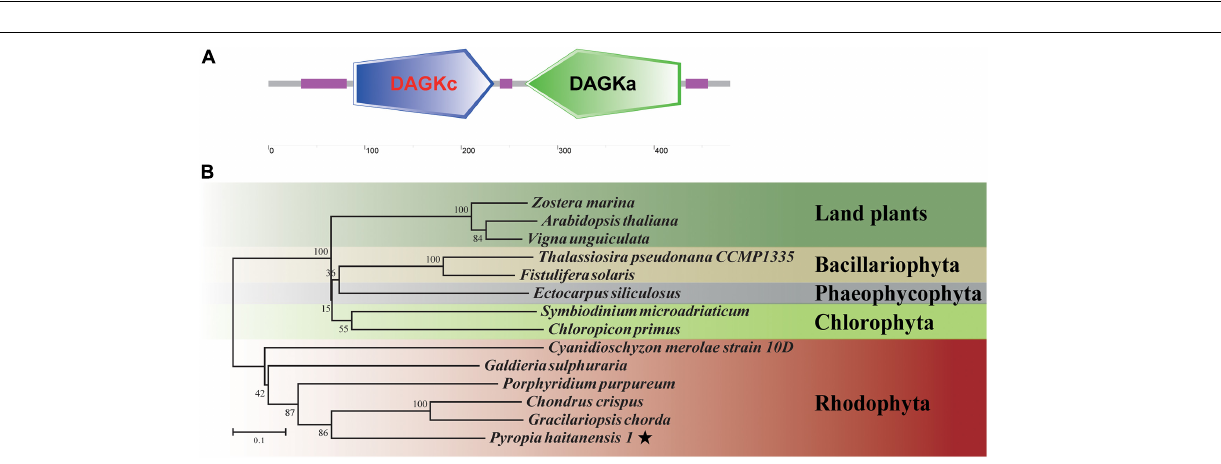
FIGURE 5 | Network construction related to phosphatidylinositol signaling system enriched from turquoise module. (A) Network for PI signal system in turquoise module. Network was constructed by extracting turquoise module genes with annotations related to PI signaling system as seed nodes, with an edge weight cut-off of 0.7. Red dots indicate hub genes in the network, yellow dots indicate nodes with connectivity of at least 100. Node size represents level of connectivity. (B) Co-expression network for hub genes in PI signal system and candidate hub-interacting genes. Sub-network was built by extracting hub genes and selected candidate co-expressed genes connected to more than one hub gene within the PI signal system network. PIKFYVE, 1-phosphatidylinositol-3-phosphate 5-kinase; PTEN-1, phosphatidylinositol-3, 4, 5-triphosphate 3-phosphatase; mtm1, phosphatases II; impa1, inositol monophosphatase 3; DGK, Diacylglycerol kinase; FGD6, pleckstrin domain-containing protein; SACM1L, phosphoinositide phosphatase SAC7; pikE, phosphatidylinositol 3-kinase; syj1, inp53-like protein; Mtmr1, myotubularin-related protein 1; PTEN-2, phosphatidylinositol-3, 4, 5-triphosphate 3-phosphatase; pikA-1, Phosphatidylinositol 3-kinase; vps34, phosphatidylinositol 3-kinase.